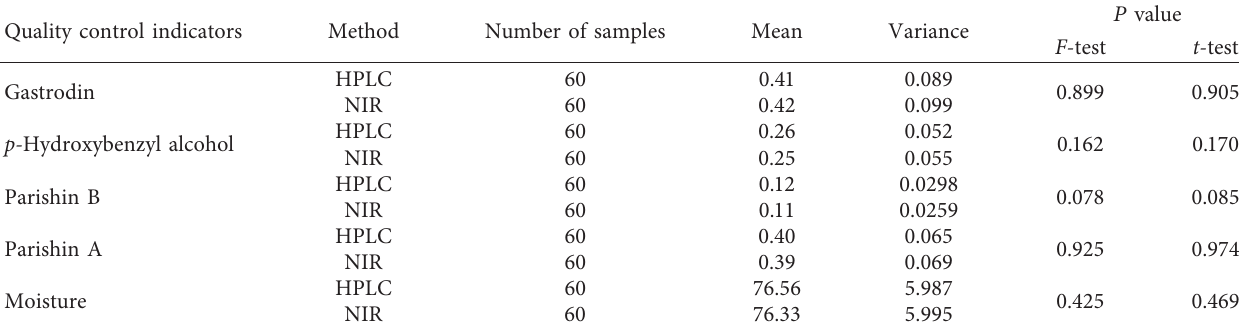
Table 7: Statistics of five indicators’ comparison between HPLC and NIR methods using a paired t -test. Quality control